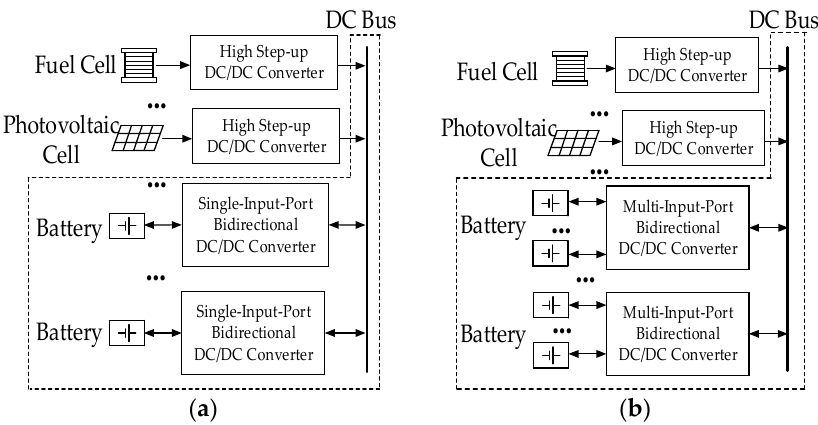
Figure 1. A DC microgrid with various battery energy storage systems. ( a ) traditional converters; ( b ) proposed converter.